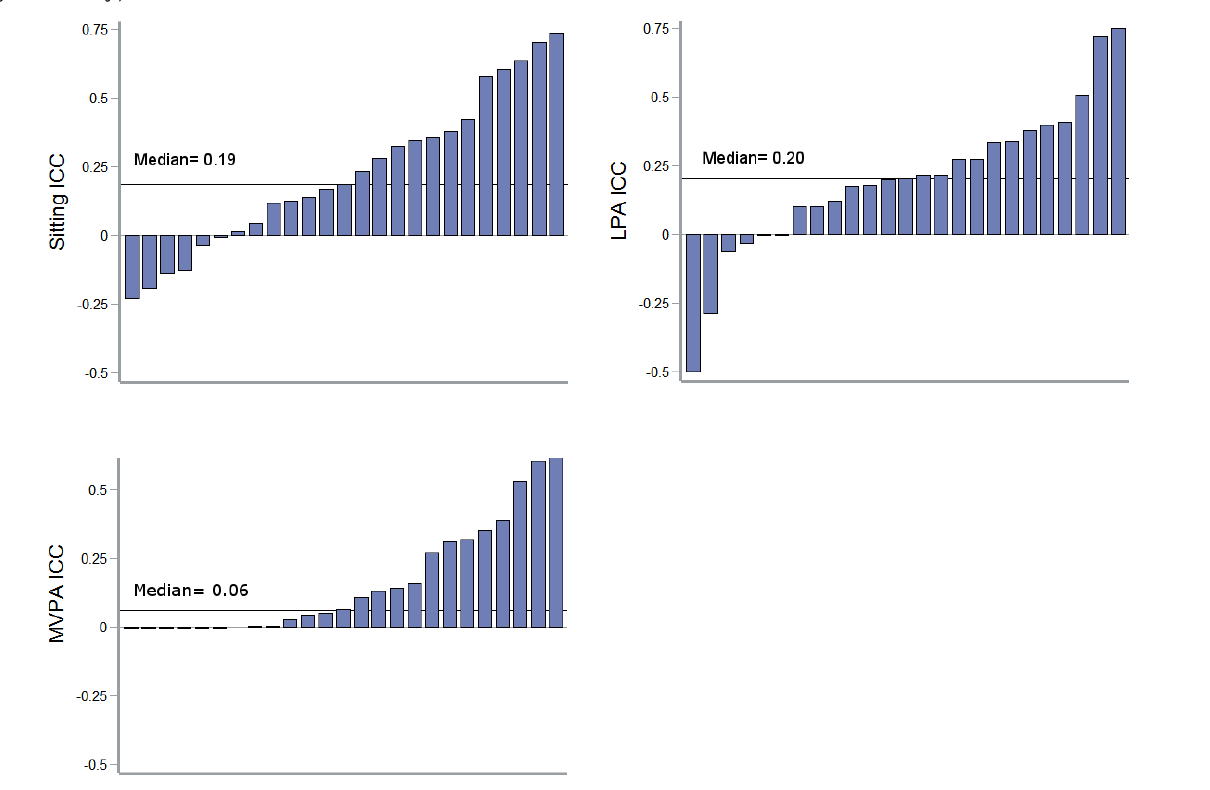
Figure 5. Individual variability in accuracy of self-reported behavior among participants. LPA: light-intensity physical activity; MVPA: moderate-vigorous physical activity; ICC: intraclass correlation.